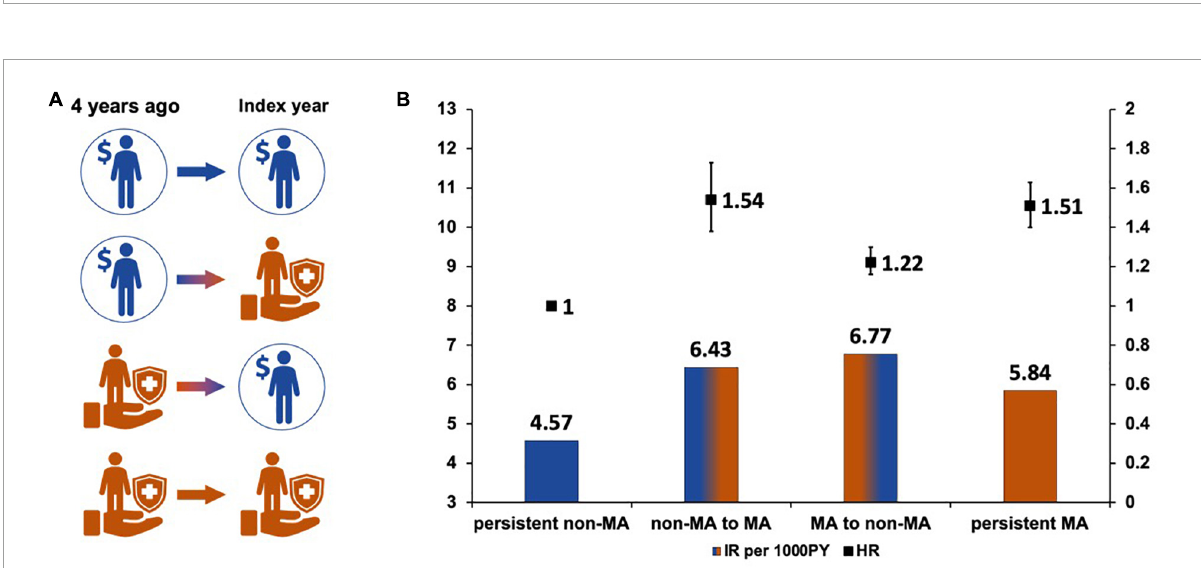
FIGURE3 Changes in socioeconomic status and the risk of atrial fibrillation. (A) Changes of socioeconomic status. (B) Hazard ratios according to the changes of socioeconomic